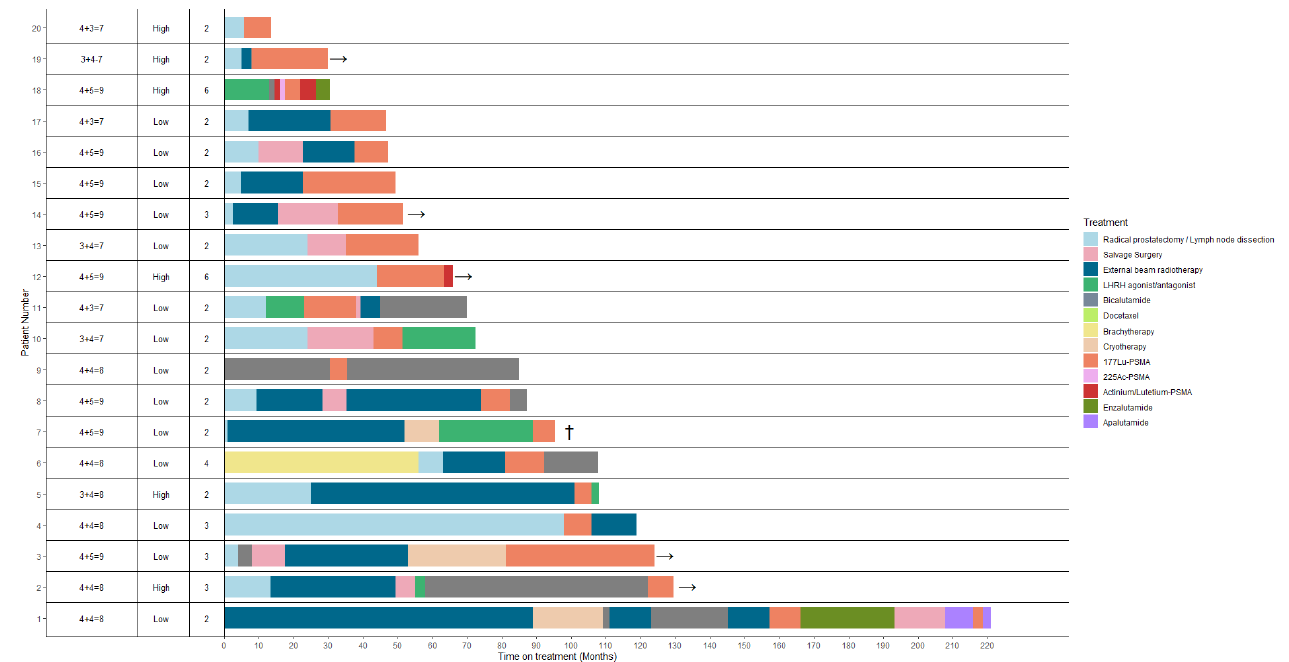
Table 2. Adverse events, possibly related to PSMA-RLT In 20 mHSPC patients.